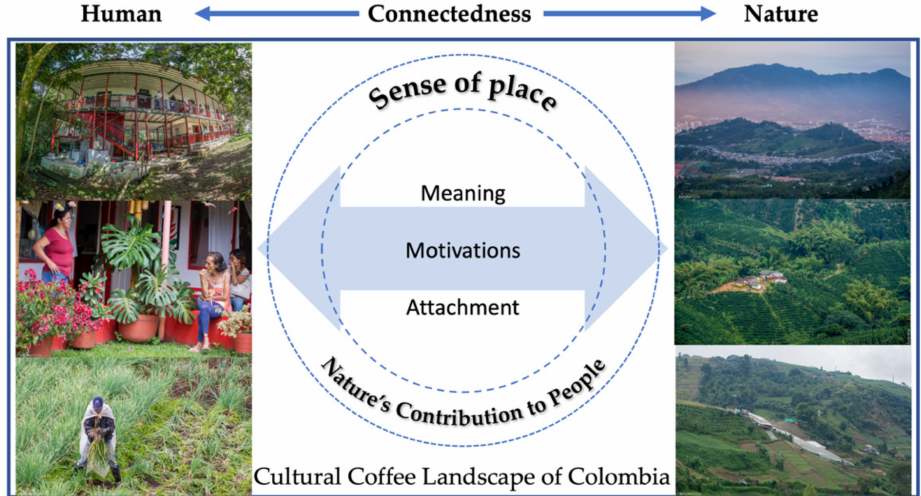
Figure 1. Conceptual framework of a sense of place through the NCP